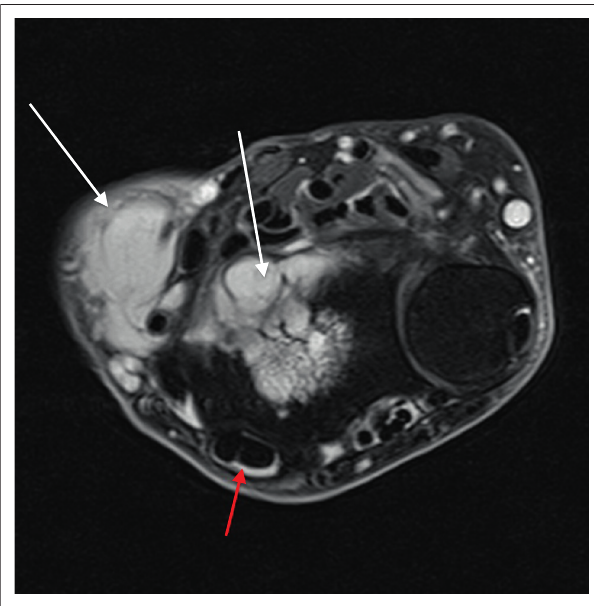
FIGURE 2: Coronal PD-weighted fat-saturated image shows a large, well- circumscribed cystic mass in the thenar eminence with extensive infiltration into the adjacent carpal bones, distal radius and pronator musculature (white arrows).